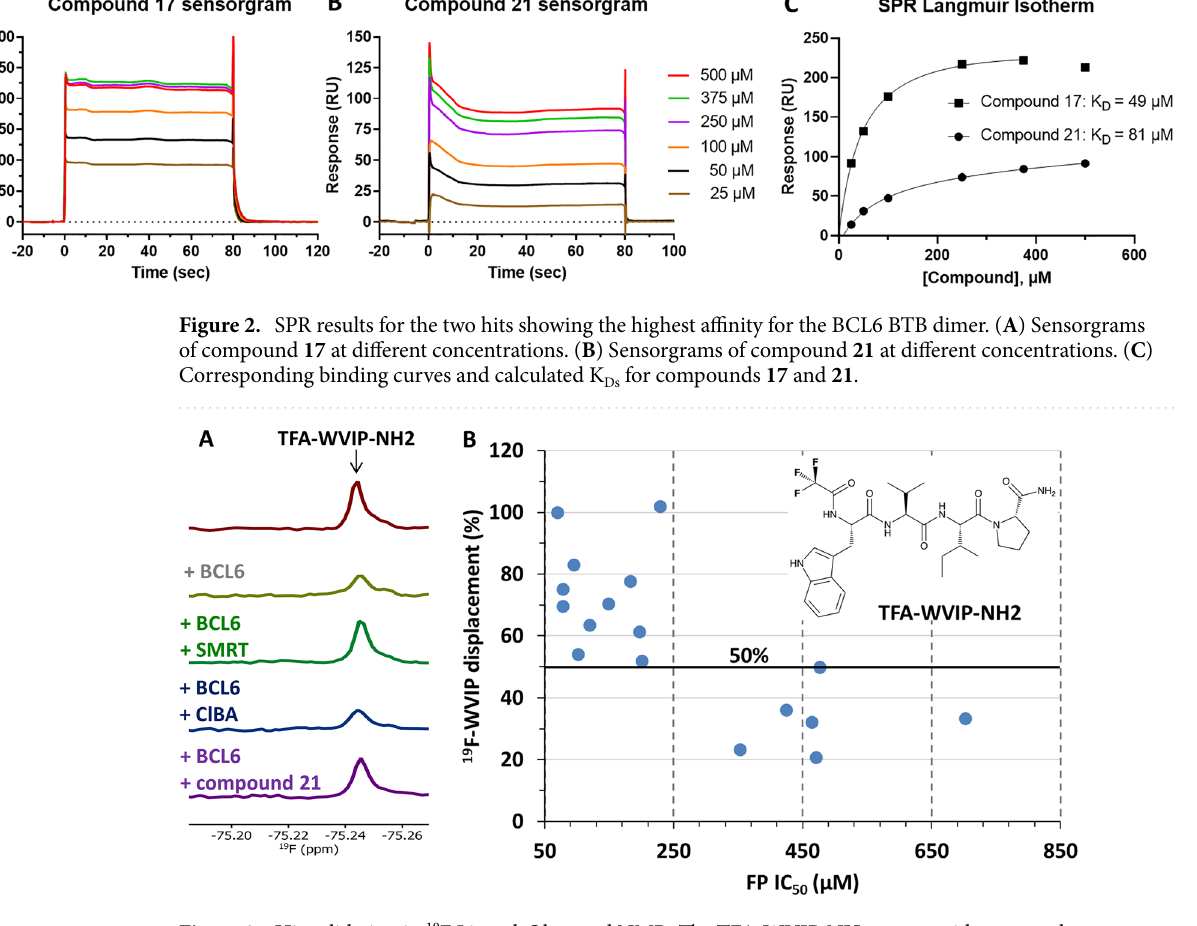
Figure 3. Hit validation in 19 F Ligand-Observed NMR. The TFA-WVIP-NH 2 tetrapeptide was used as a reporter in a 19 F-LO-NMR peptide displacement assay. ( A ) The SMRT peptide and compound 21 (bright green and purple traces), but not the negative control 4-chlorobenzoic acid (ClBA, blue trace), were able to displace the BCL6-bound TFA-WVIP-NH 2 peptide, as indicated by the recovery of the peptide fluorine signal. ( B ) The LO-NMR data correlated well with biochemical FP potency, with the 11 strongest FP hits yielding a peptide displacement greater than 50% in